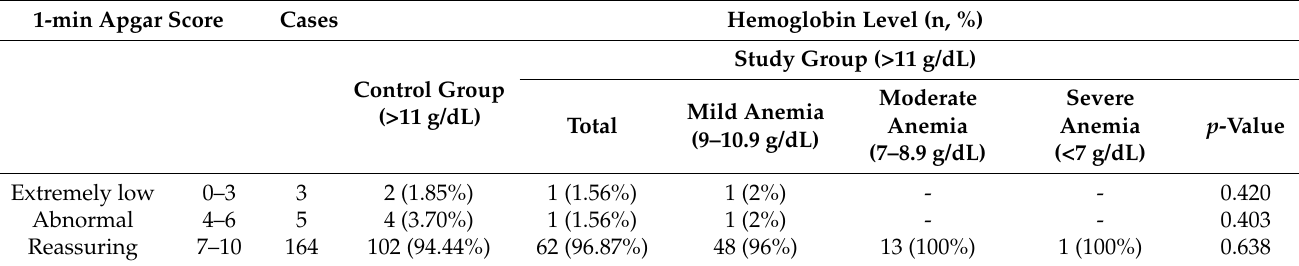
Table 5. Distribution of patients according to 1-min newborn’s Apgar score and hemoglobin level.